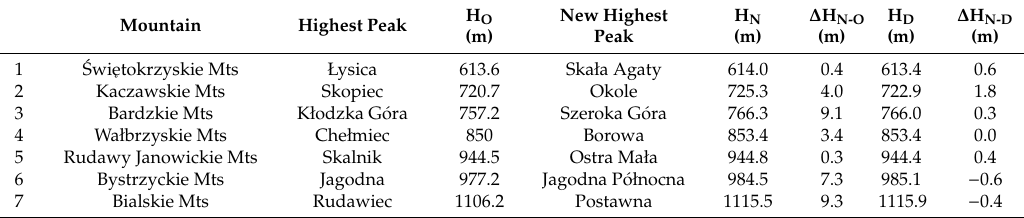
Table 2. Heights and height di ff erences between the o ffi cial highest peaks and the newly established highest